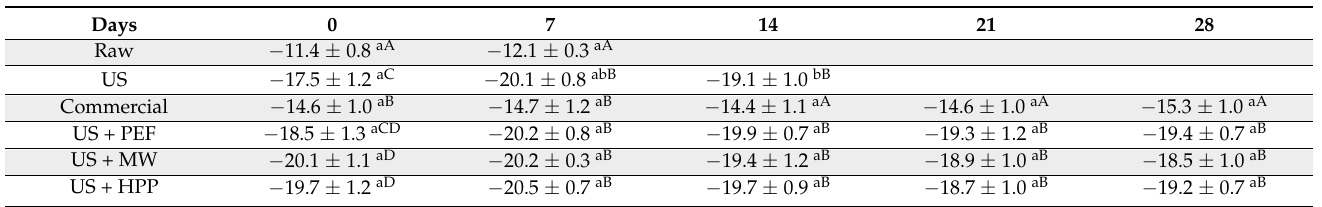
Table 1. ζ -potential values of the fat globule emulsion of the different milks throughout the shelf life stored at 4 ◦